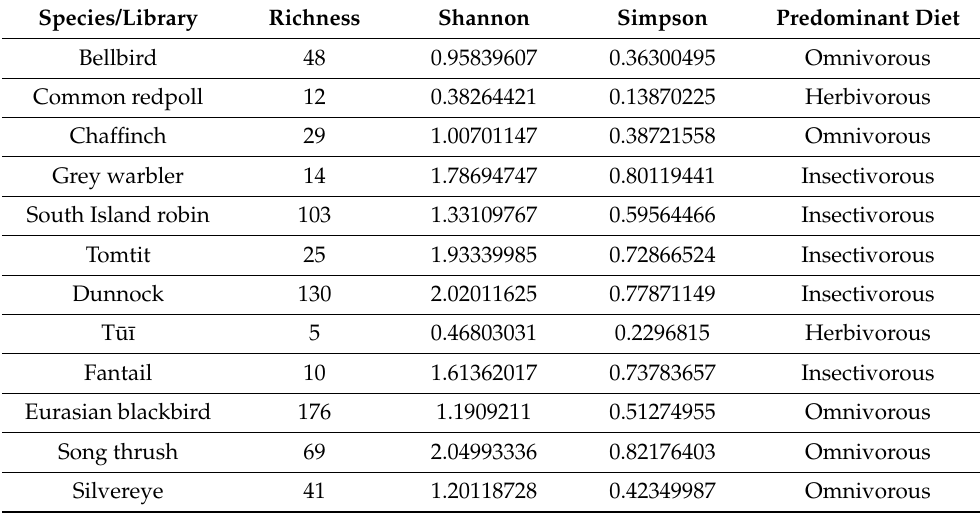
Table 2. The alpha diversity of each species/library—the richness (number of species), Shannon in- dex and Simpson index, and the predominant diet of each species.